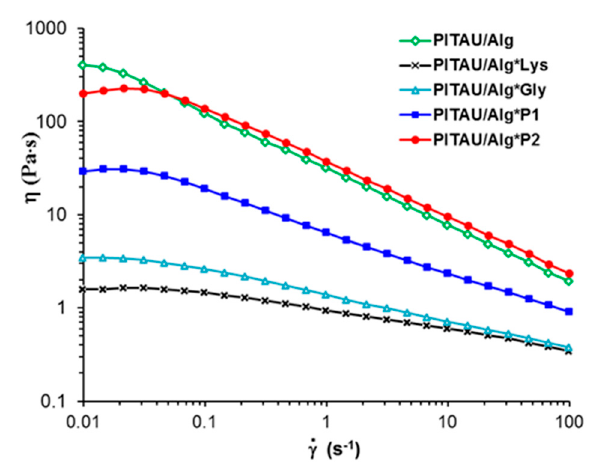
Figure 5. The apparent viscosity as a function of the shear rate for the samples investigated in stationary shear flow conditions.